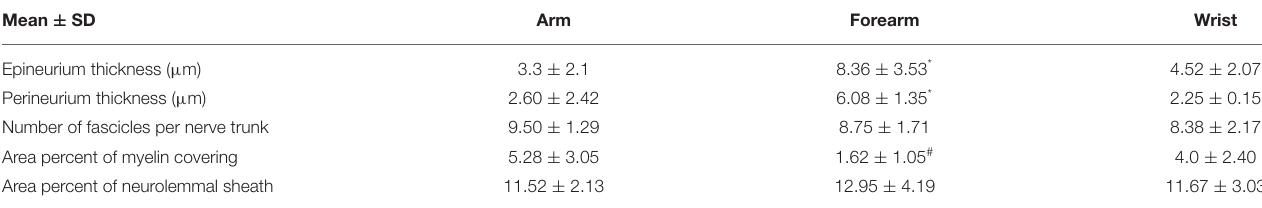
TABLE 1 | Histological examinations of the median nerve in the arm, forearm, and wrist.